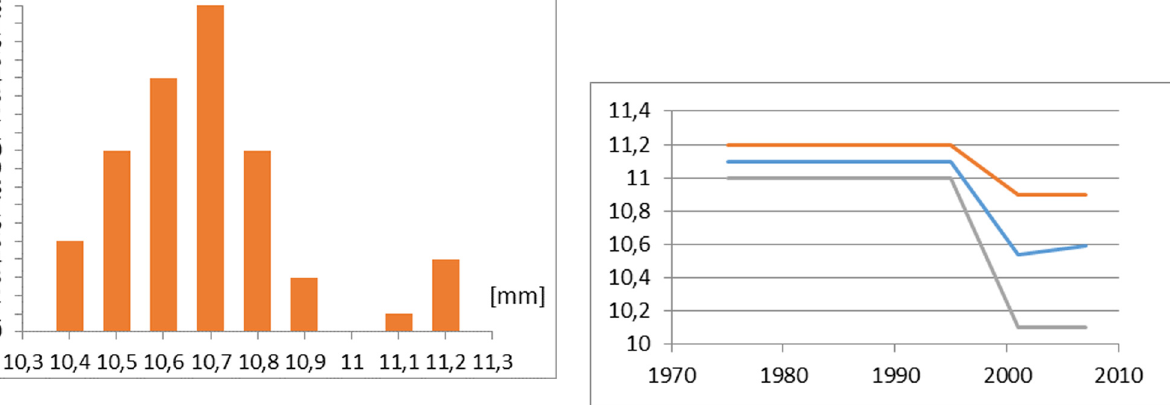
Figure 13: The progress of corrosion during the use of tank number 1 inventoried by the authors for the fi rst coating sheet ( maximum, average, and minimum values are compared here for illustrative purposes )